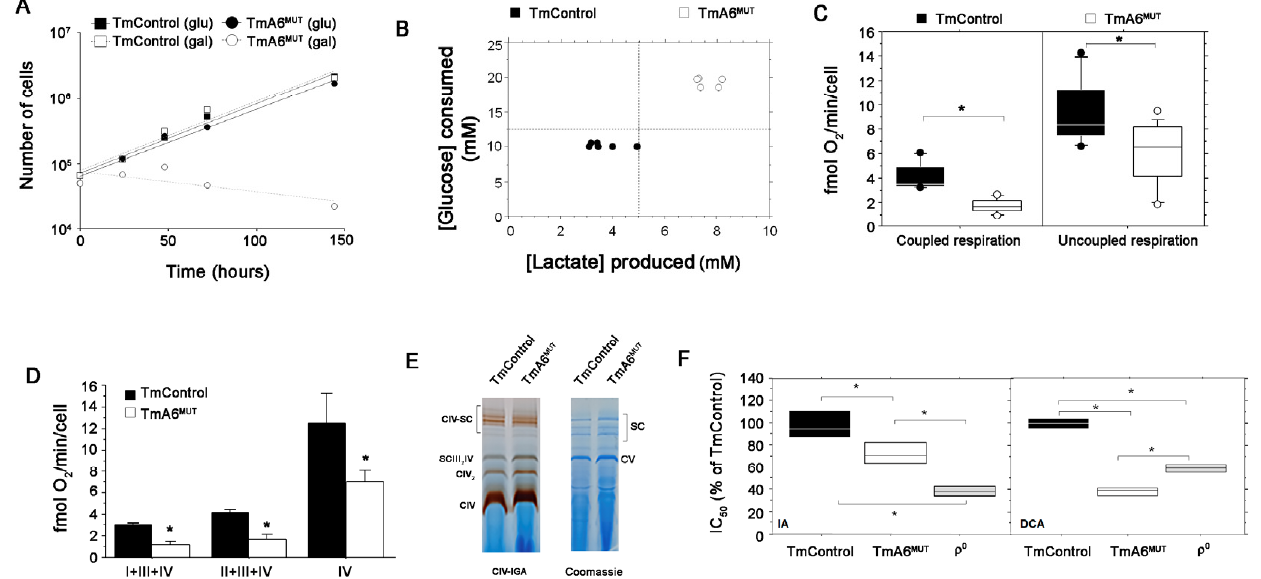
Figure 2. Analysis of mutant cells glucose dependence and OXPHOS performance: ( A ) representative growing curve of TmControl and TmA6 MUT in two different culture media: Glucose containing medium and galactose containing medium in which only OXPHOS competent cells are able to grow; ( B ) glucose consumption and lactate production by TmControl and TmA6 MUT cell semi-confluent cultures in 24 h. The graph represents the concentrations relationship between lactate produced and glucose consumed, measured in cell culture media collected from a 24 h culture (80% of confluence); ( C ) endogenous (left) and maximal (right) oxygen consumption rate measurement in intact cells ( n = 9 and 13 for TmControl and TmA6 MUT , respectively; p < 0.0001 for endogenous respiration and p < 0.05 for maximal respiration); ( D ) oxygen consumption of digitonin-permeabilized cells in the presence of specific electron donors for complex I (glutamate + malate), complex II + III (succinate + G3P) and complex IV (TMPD) ( n = 2 and 3 for TmControl and TmA6 MUT , respectively; p = 0.0071, p = 0.0072 and p = 0.048 for complex I + III + IV, complex II + III + IV and complex IV, respectively). ( E ) Pattern of mitochondrial complexes and supercomplexes analysed by BN-PAGE followed by enzymatic In Gel Activity for complex IV (left) or by coomassie staining (right); and ( F ) IC 50 expressed as % of that of TmControl cells for the indicated inhibitors in TmA6 MUT and ρ 0 cells ( n = 3 in all cases for IA and n = 3, 3 and 2 for TmControl, TmA6 MUT and ρ 0 cells, respectively, for DCA; p < 0.05 for all the pairs and inhibitors). All values are given as mean ± SD of the mean. Asterisks indicate significant differences respect to control cells, tested by ANOVA post-hoc Fisher PLSD ( p < 0.05 or as indicated in each panel